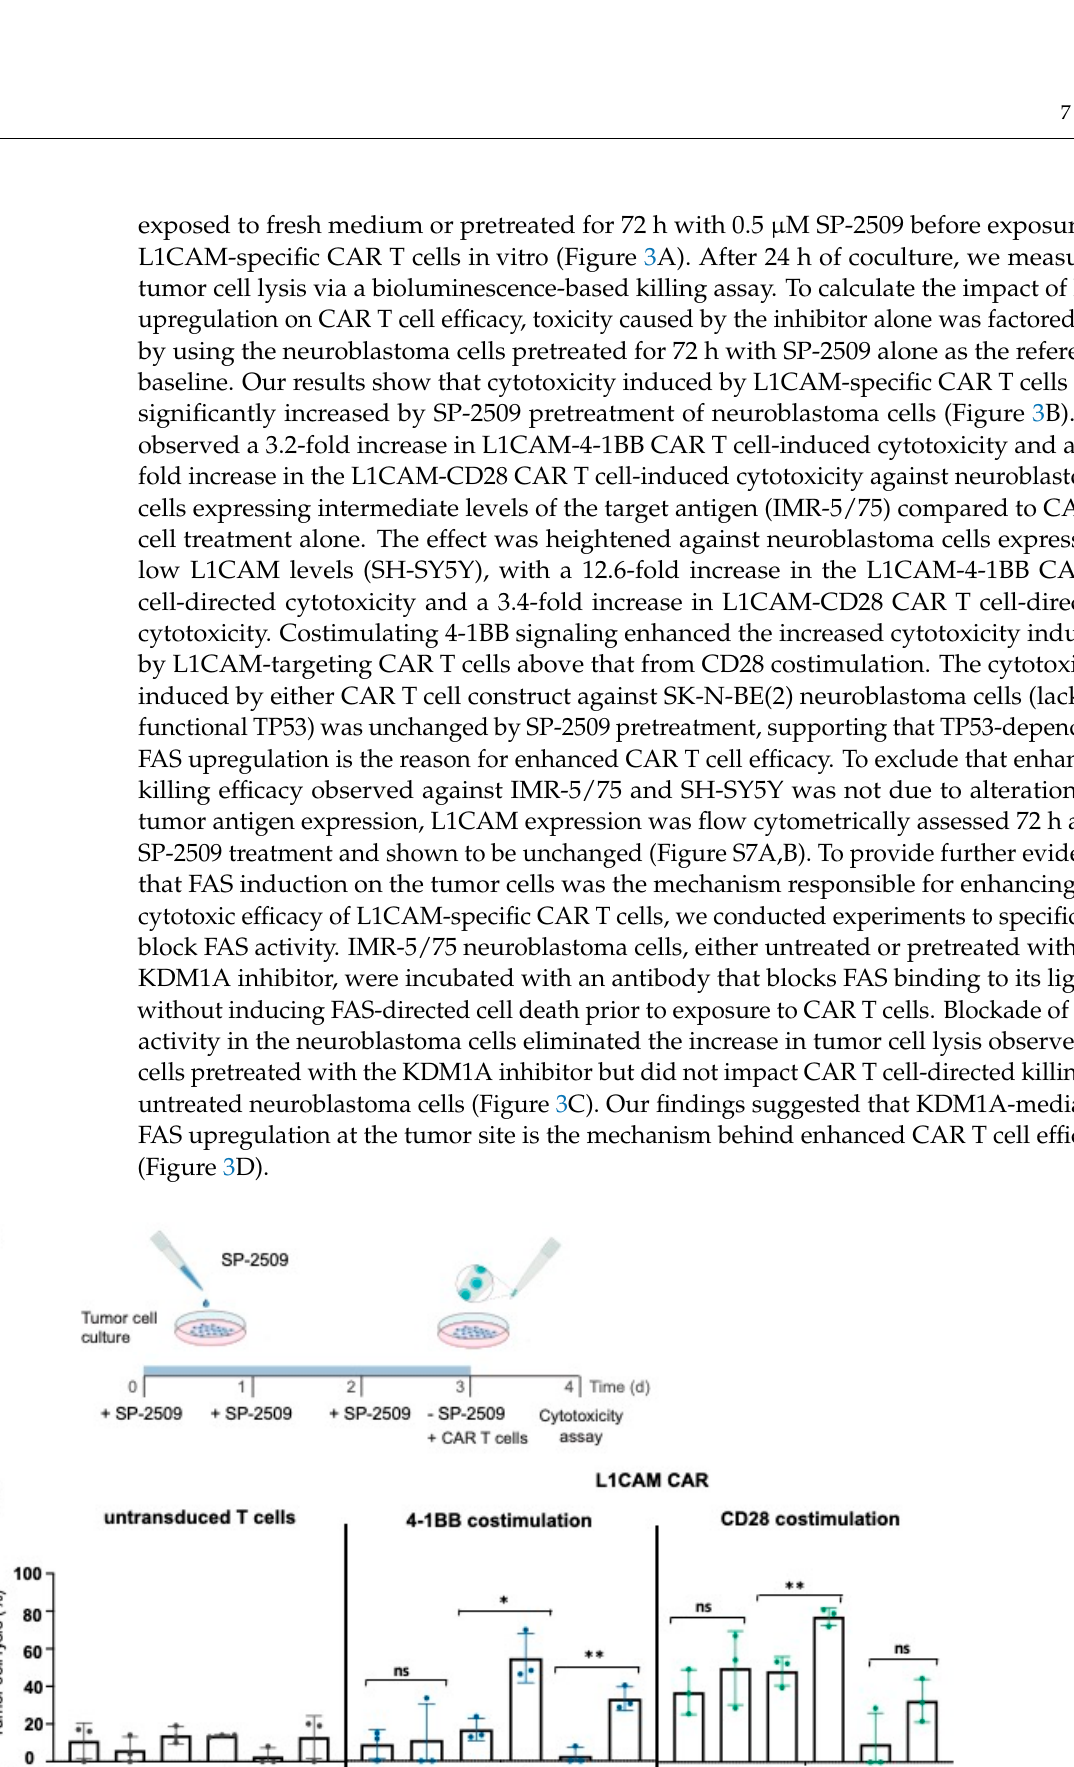
Figure 3. Combining KDM1A inhibition with CAR T cell therapy killed neuroblastoma cells expressing low tumor anti- gen levels via the FAS-FASL axis. ( A ) Experimental timeline for the combination therapy. ( B ) Killing efficacy of L1CAM-specific CAR T cells after 24 h coculture of neuroblastoma cell lines treated with 0.5 µM SP-2509 (or untreated controls) at an effector:target ratio of 1:5 (mean ± SD, n = 3). ( C ) Untreated or KDM1A-pretreated SH-SY5Y cells were incubated for 1 h in the presence or absence of the human neutralizing anti-FAS antibody before measuring the tumor cell lysis by L1CAM-specific CAR T cells cocultured with the tumor cells at an effector:target ratio of 1:5 for 24 h (mean ± SD, n = 3). ( D ) Illustration of FAS regulation in tumor cells. ns not significant * p ≤ 0.05, ** p ≤ 0.01.